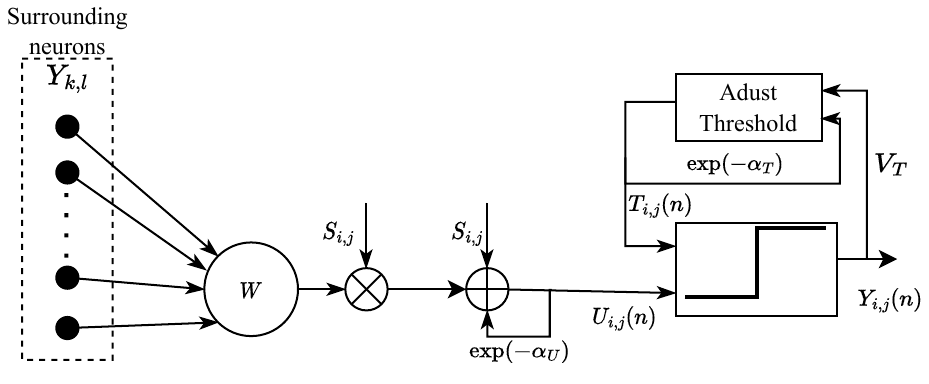
Figure 3. The modified PCNN model.